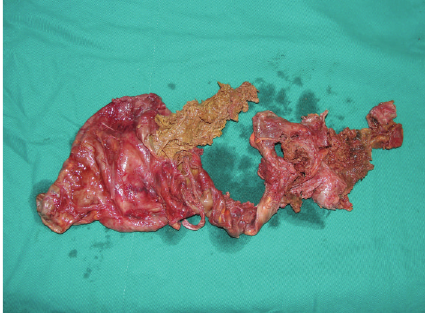
Figure 6: The excised CEH with villous formation.